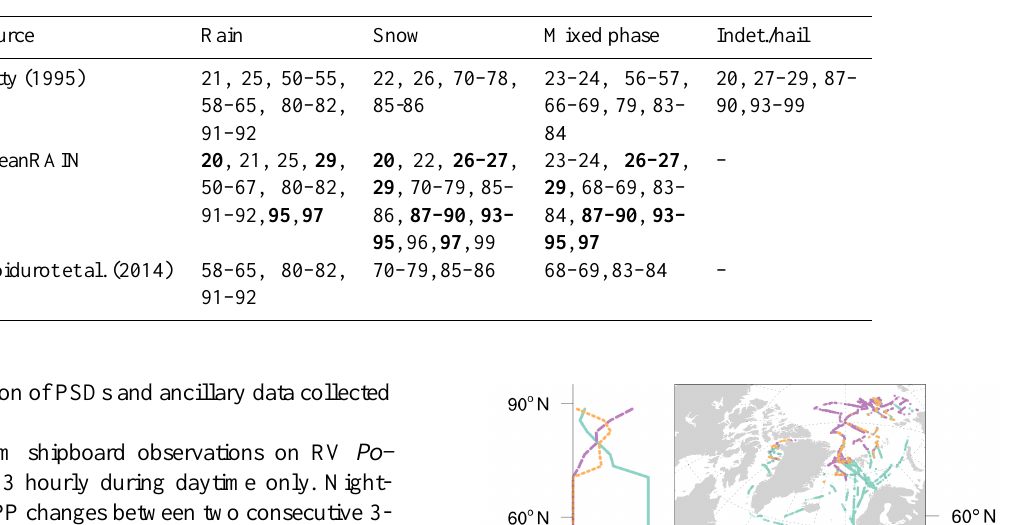
Table 1. Translation of WMO present weather codes ww (WMO, 2015) into the three PPs from Petty (1995), Froidurot et al. (2014), and OceanRAIN. ww codes printed in bold can be translated into multiple PPs in OceanRAIN depending on ancillary data. “Indet./hail” denotes indeterminate precipitation or hail used for classification in Petty (1995).